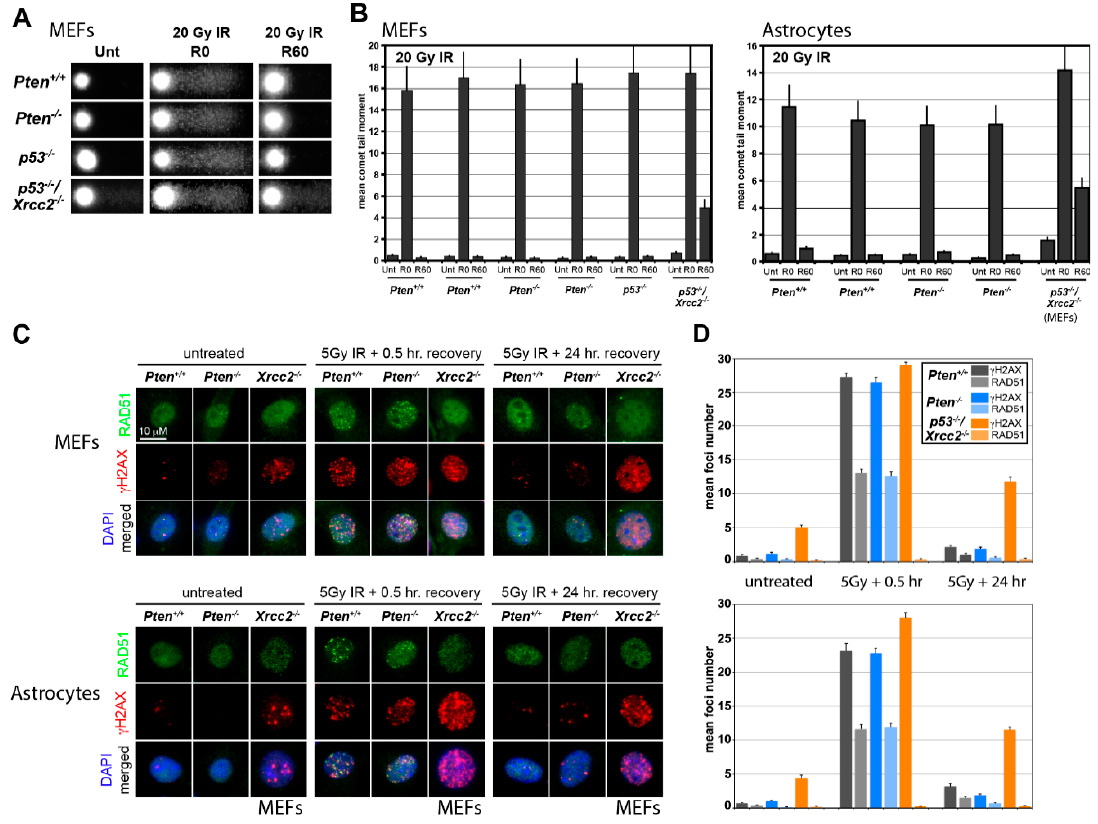
Figure 2. DNA damage analysis of Pten-deficient primary murine mouse embryonic fibroblasts (MEFs) and astrocytes. ( A ) Representative images from the alkaline comet analysis of primary Pten +/+ , Pten − / − , p53 − / − and Xrcc2 − / − ; p53 − / − MEFs following 20 Gy irradiation (R0) and 60 min post ‐ irradiation recovery (R60). Although comet tail lengths appear equivalent in all genetic cell subtypes following radiation, no residual tails remain in Pten +/+ , Pten − / − and p53 − / − MEFs 60 min following radiation, while Xrcc2 - / - ; p53 - / - MEFs show a residual tail. ( B ) Bar graphs represent mean comet tail moments plus the standard error of means (s.e.m.) derived from the alkaline comet analysis on primary MEFs and astrocytes. Experiments were repeated in triplicate ( n = 3), where a minimum of 100 cells were measured per line / treatment in each experiment; N ≥ 300 total independent comet tail moments were measured per line / treatment. Wild-type and Pten − / − MEFs and astrocytes show equivalent repair activity following irradiation. Similar to the wild-type and Pten − / − cells, p53 - / - cells show no apparent DNA repair defect, while Xrcc2 − / − , p53 − / − cells display delayed HR-dependent repair following DNA strand break damage [44]. ( C ) Representative fluorescent γ H2AX and RAD51 foci micrographs derived from primary Pten +/+ , Pten − / − and Xrcc2 − / − ; p53 − / − MEFs and astrocytes following irradiation and 24 h post-irradiation recovery. In untreated Pten +/+ and Pten − / − cells, both γ H2AX and RAD51 foci numbers are minimal, while the γ H2AX foci are apparent in Xrcc2 − / − , p53 − / − cells. Following irradiation, Pten +/+ and Pten − / − cells develop γ H2AX and RAD51 foci, while Xrcc2 − / − , p53 − / − cells only develop γ H2AX foci. RAD51 foci fail to form in Xrcc2 − / − , p53 − / − cells regardless of treatment despite expression of the RAD51 protein consistent with HR deficiency. Following 24 h of post-irradiation recovery, γ H2AX and RAD51 foci are absent in Pten +/+ and Pten − / − cells, indicating repair of the radiation-induced damage, while pervasive γ H2AX foci remain in Xrcc2 − / − , p53 − / − cells indicating unrepaired DNA strand break damage. ( D ) Bar graphs represent mean γ H2AX and RAD51 foci per cell (foci / cell) quantification data of primary MEFs and astrocytes following 5 Gy radiation and recovery 24 h post-radiation. Experiments were repeated in triplicate ( n = 3), where a minimum of 30 cells were measured per treatment; total N ≥ 90 independent cells measured per line / treatment. Error bars represent the standard error of means (s.e.m.).